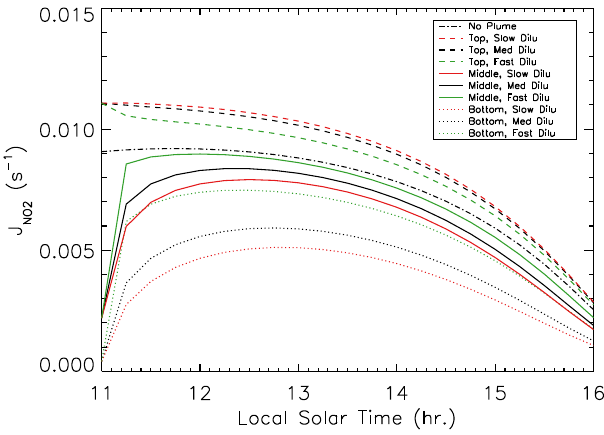
Figure 4. NO 2 photolysis rates (s − 1 ) vs. local time. Red, black, and green are for the slow, best fit (medium), and fast plume dilution rates. Dashed lines are for photolysis rates above the plume, solid lines are for the middle of the plume, and dotted lines are for the bottom of the plume, as described in the text. The black dot-dashed line is the clear-sky (no plume) photolysis